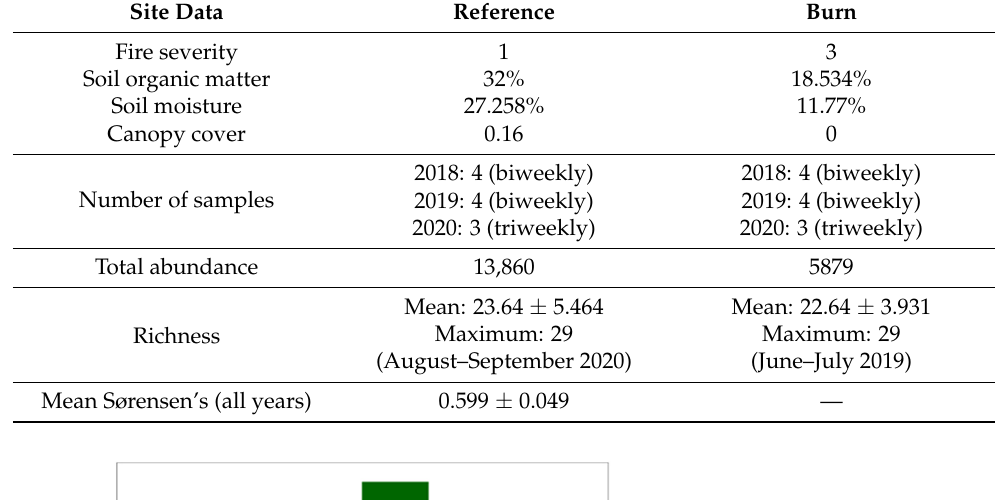
Table 1. Summary table for site characteristics, richness, and mean similarity between burn and reference sites for all years. All site characteristic data were collected during the spring of 2019.